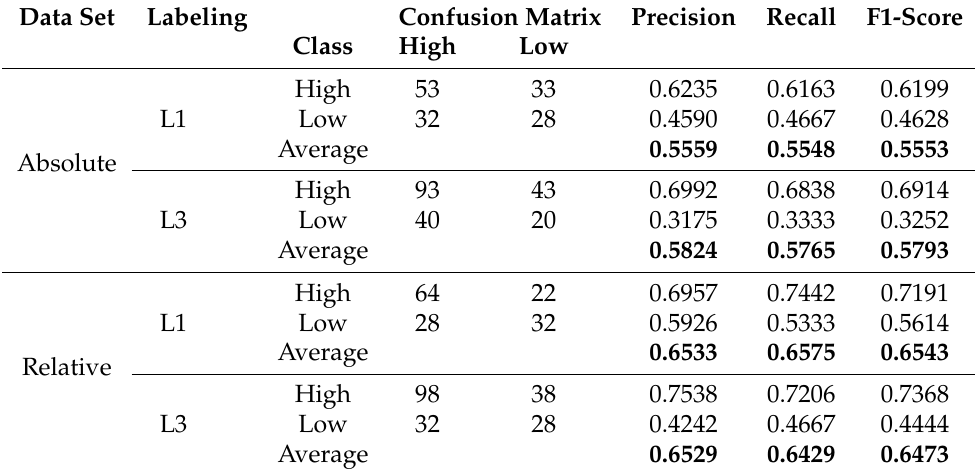
Table 10. Summary of classification results for the level of arousal. The values marked bold are weighted averages of precision, recall and